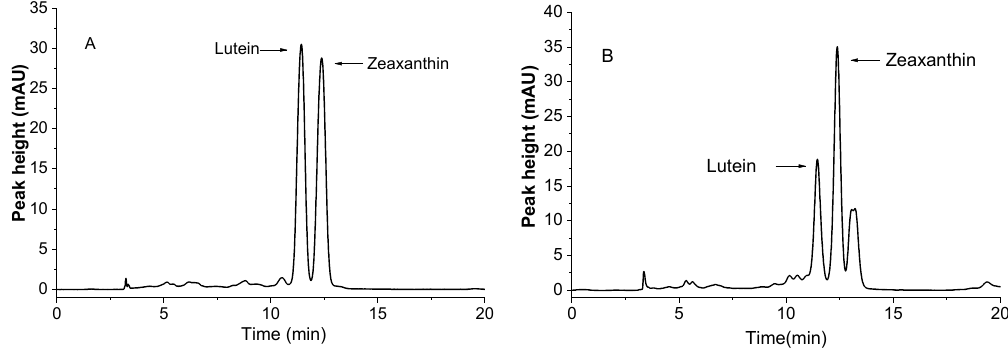
Figure 1. ( A ) The standard chromatogram and ( B ) determination chromatogram of zeaxanthin and lutein in corn gluten meal.